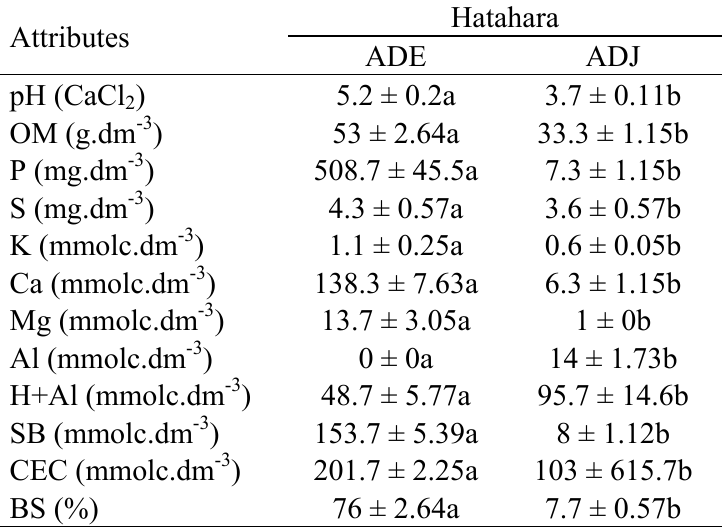
Table 3. Chemical attributes of ADE and ADJ soil